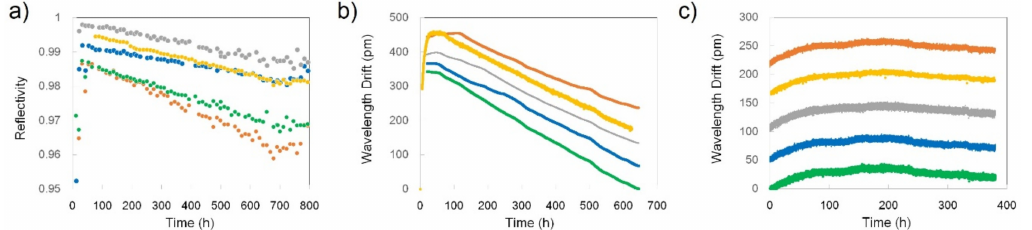
Figure 24. ( a ) Change in the reflectivity of Type-b FBGs at 1000 ◦ C (from 0 h to 700 h) and at 900 ◦ C (from 700 h to 800 h); ( b ) Wavelength drift of Type-b FBGs at 1000 ◦ C; ( c ) Wavelength drift at 900 ◦ C of the Type-b FBGs that were pre-annealed at 1000 ◦ C shown in ( b ).